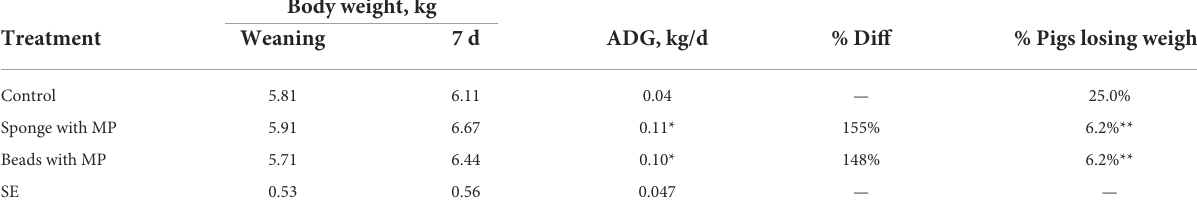
TABLE 2 Least squares means and % difference (Study 1) during the first 7 days after weaning.